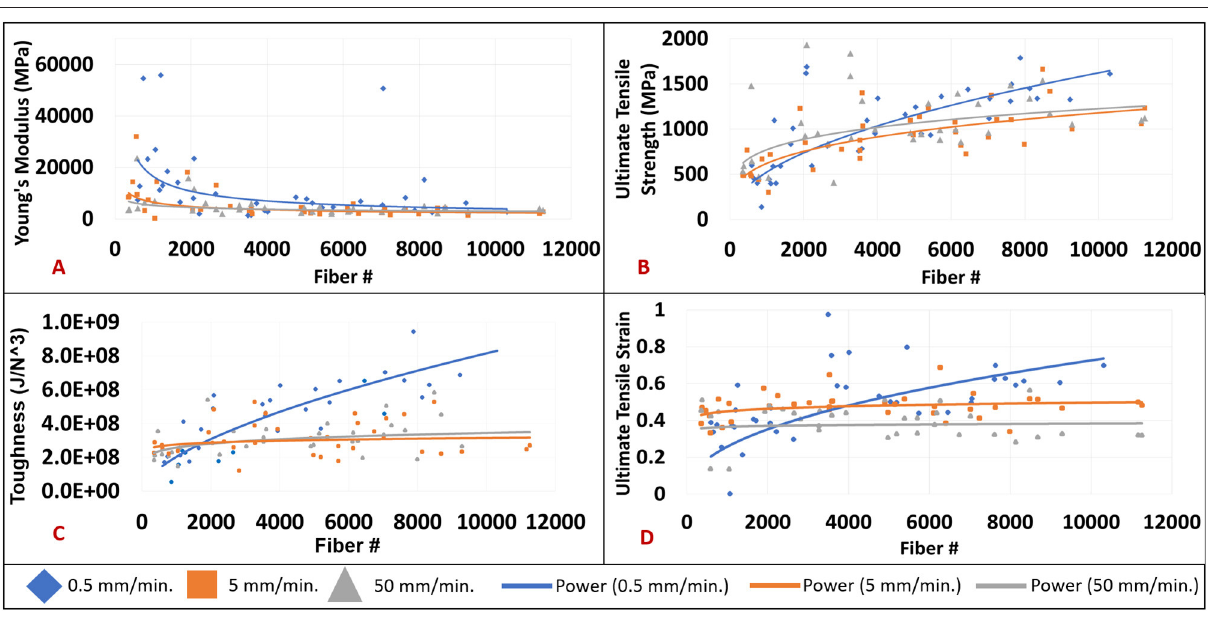
(9–2 MPa), and Young’s modulus at 0.1–0.3 strain with increasing mat thickness from 18.64 to 75.63 µ m (Mubyana et al., 2016).